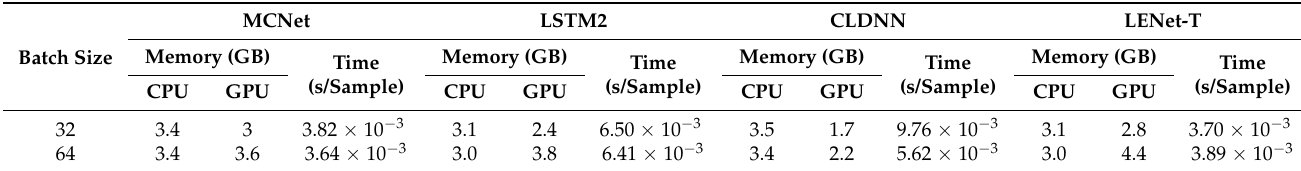
Table 13. Model inference speed with a signal length of